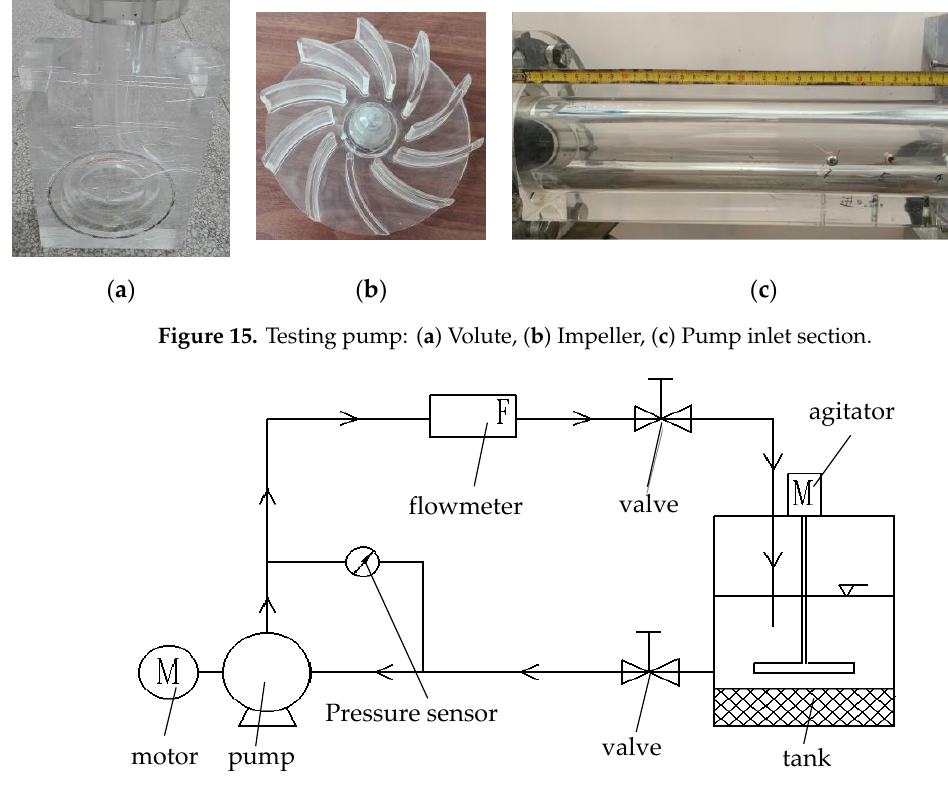
Figure 16. Testing apparatus schematic diagram.